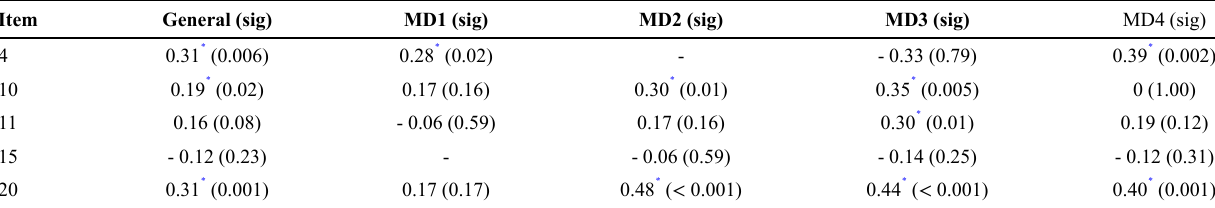
Table 3 - Inter-rater reliability from the five items checklist and its movement descriptors (MD) of the high upper limb in front crawl proposed in the second